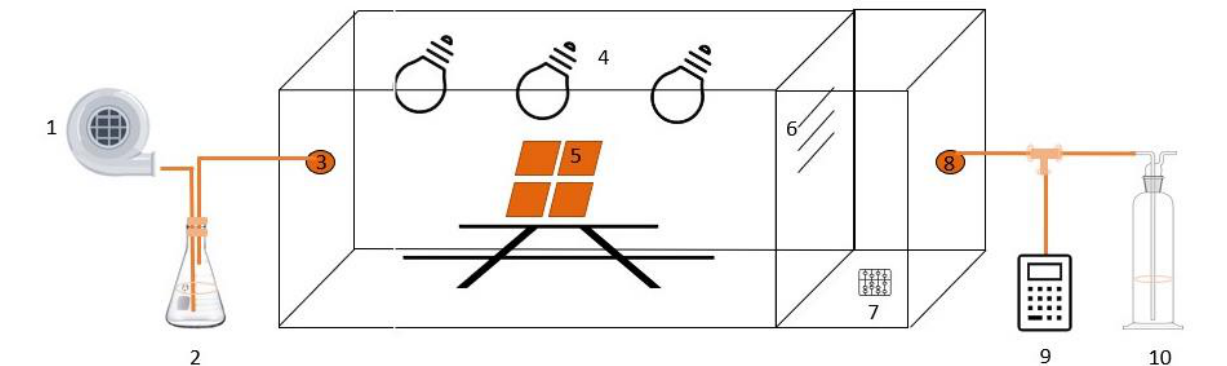
Figure 5. The reaction mechanism of experimental inquiry: ( 1 ) air pump; ( 2 ) Erlenmeyer flask with an aqueous ammonia solution; ( 3 ) inlet; ( 4 ) irradiation emission panel; ( 5 ) rubber tiles; ( 6 ) compartment with three ventilation slots; ( 7 ) Arduino sensor for temperature and humidity; ( 8 ) outlet; ( 9 ) gas analyzer; and ( 10 ) rinse.